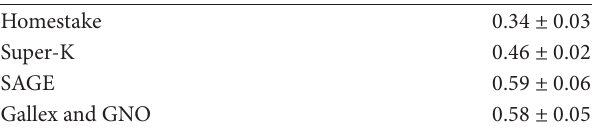
Table 1: Ratios of the observed versus expected neutrino rates in the four solar neutrino experiments (before SNO, see